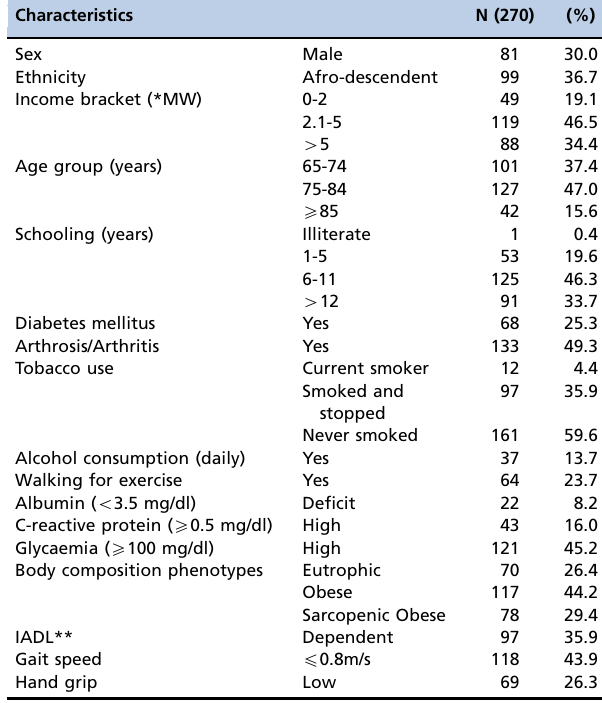
Table 1 - Frequency of socioeconomic and demographic characteristics, morbidities, lifestyle, biomarkers, body composition, and functional phenotypes